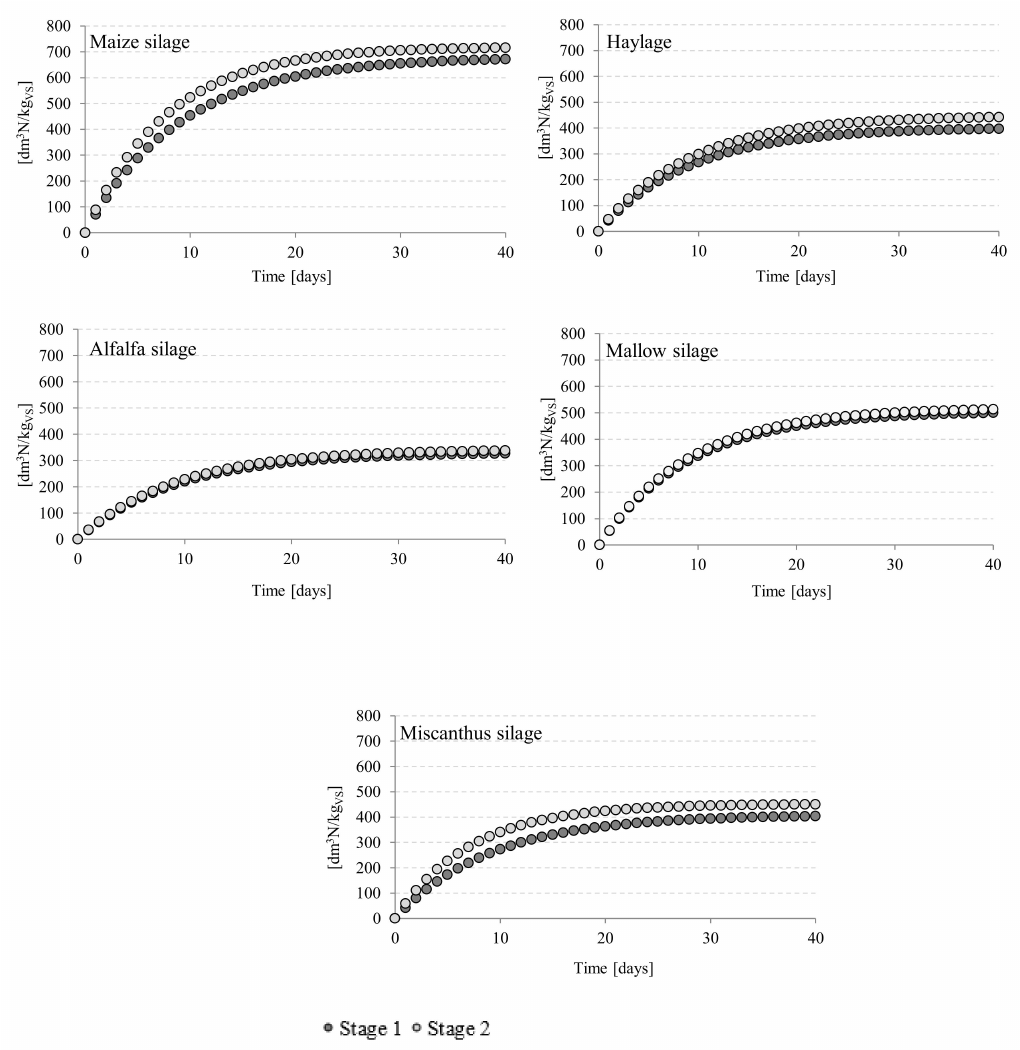
Figure 1. Details of the biogas production process in different experimental variants.